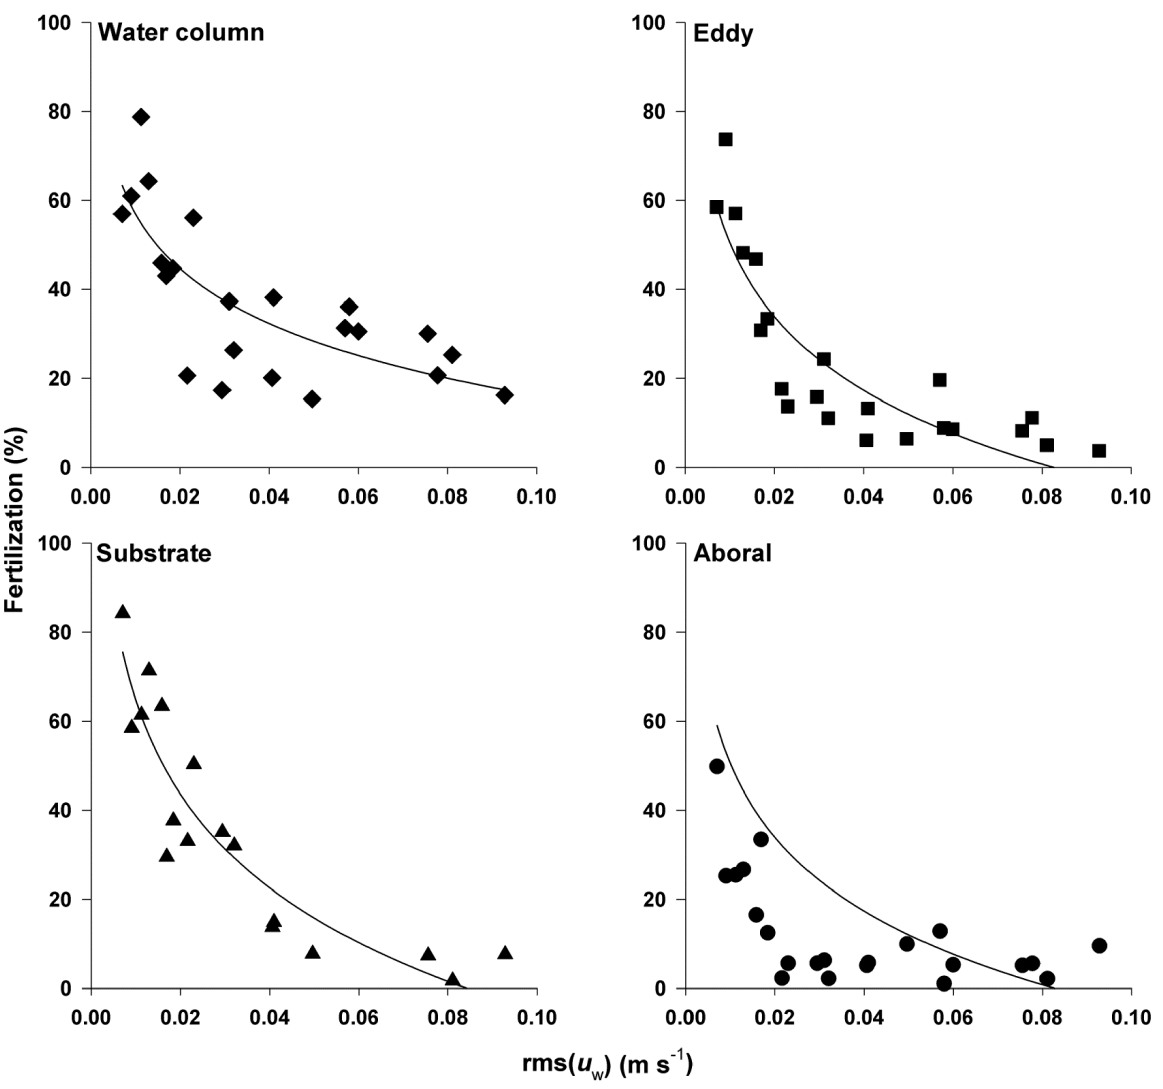
Figure 4. Variation in fertilization as a function of flow. Mean percent fertilization (PF) is plotted as a function of rms( u w ) (m s 2 1 ) in the four sampling locations: water column, wake eddy, substrate, and aboral surface. Symbols represent weighted mean of all the time points. Lines represent a nonlinear curve fit to the untransformed data. PF was strongly dependent on rms( u w ) (m s 2 1 ) for all sampling locations (Table 1).